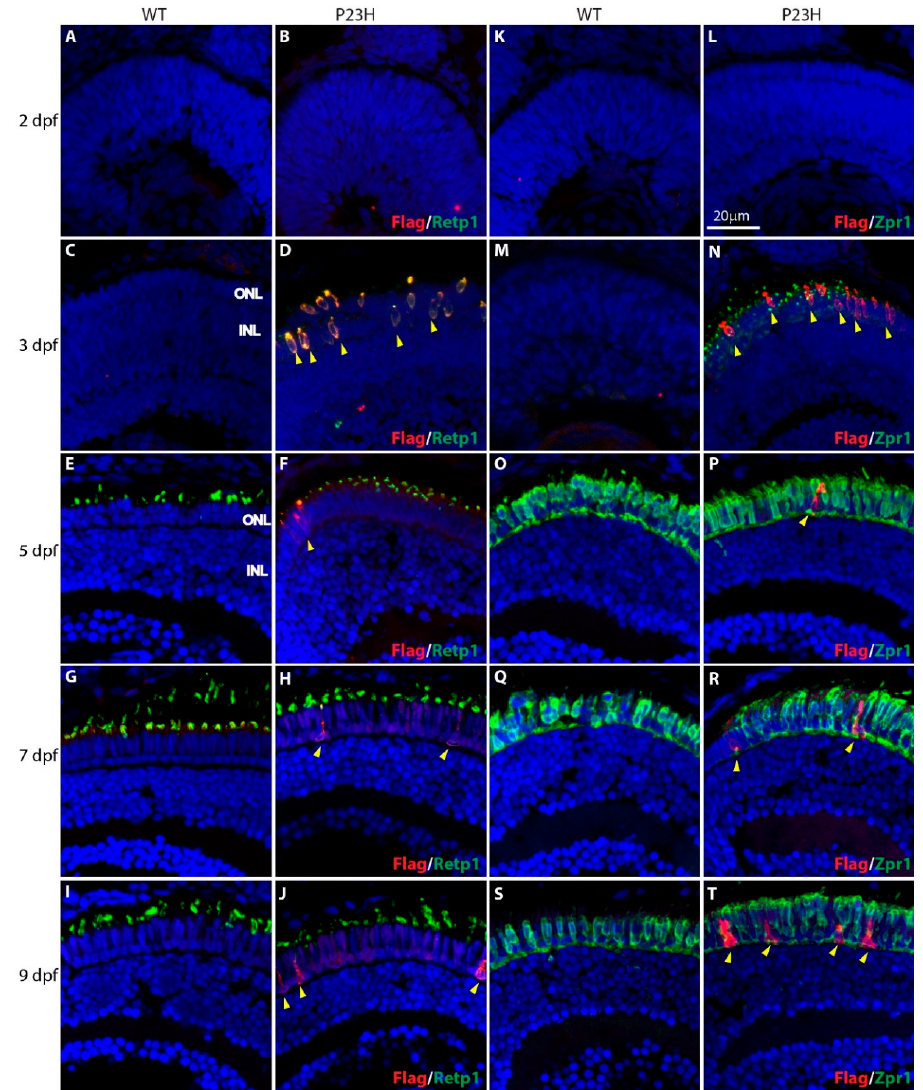
Figure 2. Expression of P23H Flag-tagged rhodopsin at early stages of photoreceptor development in wild type (WT) and P23H transgenic (P23H) zebrafish. Expression of P23H mutant rhodopsin (Flag; red) and rhodopsin (Retp1; green) at 2 dpf ( A , B ), 3 dpf ( C , D ), 5 dpf ( E , F ), 7 dpf ( G , H ), and 9 dpf ( I , J ). Expression of Flag-tagged P23H mutant rhodopsin (red) compared to double cones (Zpr1, green) at 2 dpf ( K , L ), 3 dpf ( M , N ), 5 dpf ( O , P ), 7 dpf ( Q , R ), and 9 dpf ( S , T ). Yellow arrowheads denote cells expressing P23H mutant rhodopsin. Nuclei labeled with DAPI are blue. ONL: outer nuclear layer; INL: inner nuclear layer. Scale bar in L applies to all